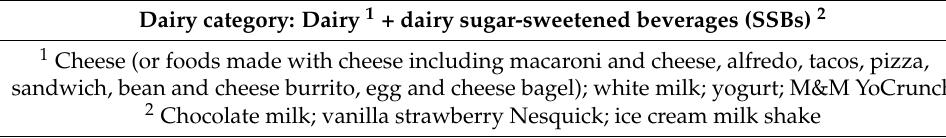
Table 1. Food categories consumed by early adolescents aged 10–13 years. Dairy category: Dairy 1 + dairy sugar-sweetened beverages (SSBs) 2 1 Cheese (or foods made with cheese including macaroni and cheese, alfredo, tacos,